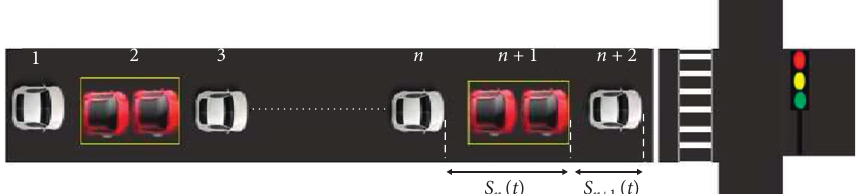
Figure 3: A mixed traffic flow platoon of eleven vehicles including AC vehicles platoon and HD vehicles proceeds as the traffic signal shifts from red to green.